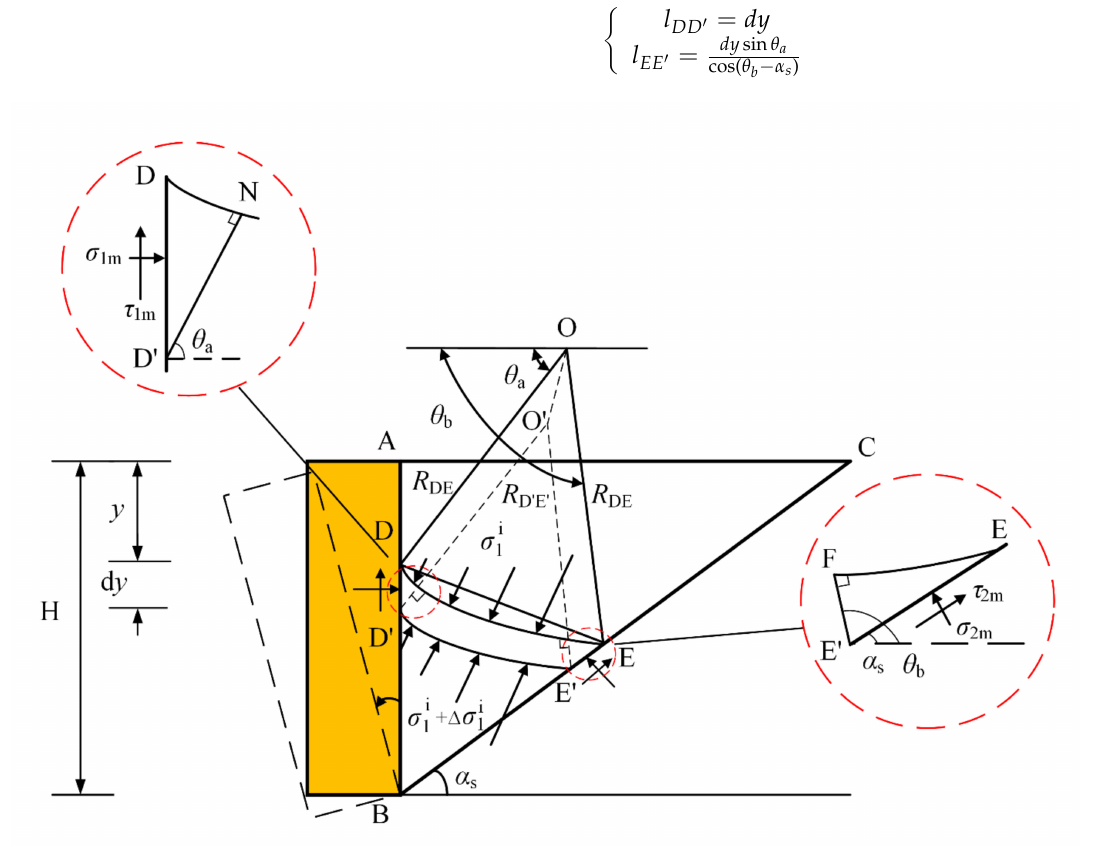
Figure 3. Force analysis of a curved thin-layer